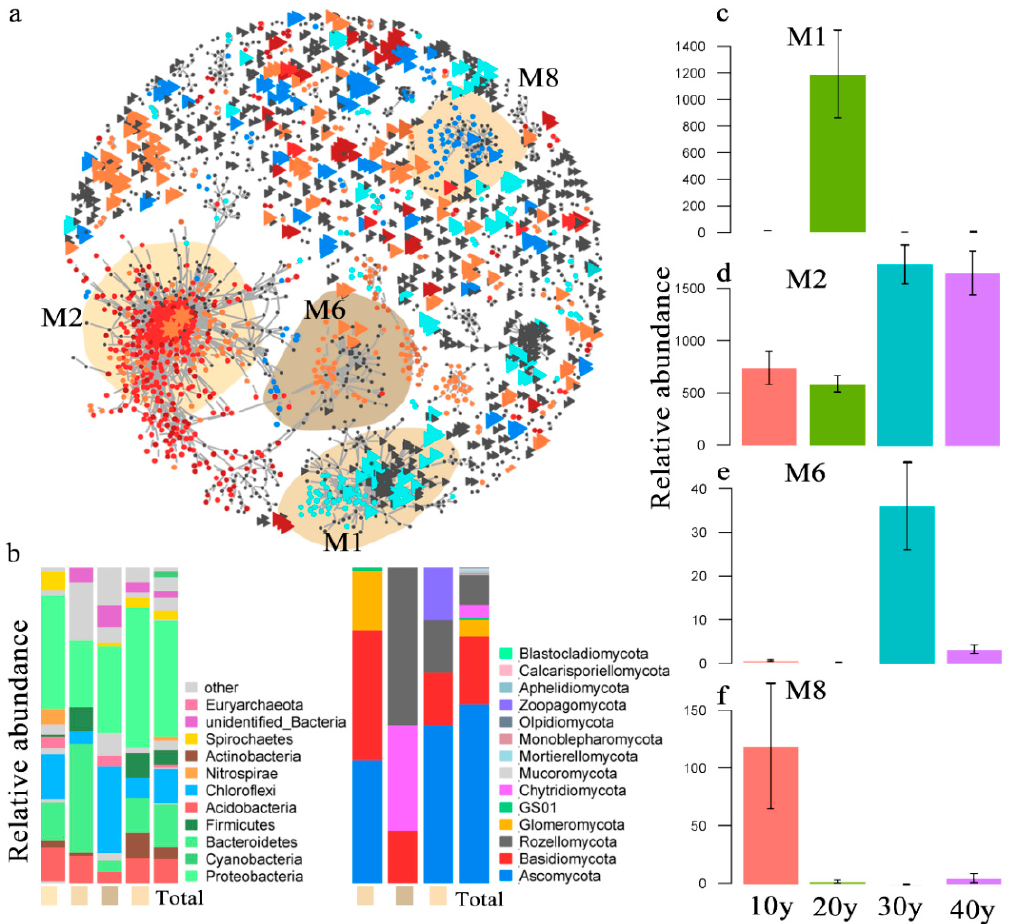
Figure 4. ( a ) Co-occurrence patterns of core microbiota, co-occurrence networks showing significant correlations (R > 0.7, p < 0.001; indicated with gray lines) between bacterial and fungal OTUs of reed rhizoplane microorganisms. Circles indicate bacteria, triangles indicate fungi, and keystone OTUs are represented with asterisks. Core taxa are colored according to their association with the different recovery times (gray OTUs were insensitive to recovery times). Shaded areas represent the network modules containing OTUs. ( b ) Qualitative taxonomic composition of core taxa in the module reported as proportional OTU numbers per phylum (bacteria and fungi) at different recovery times.